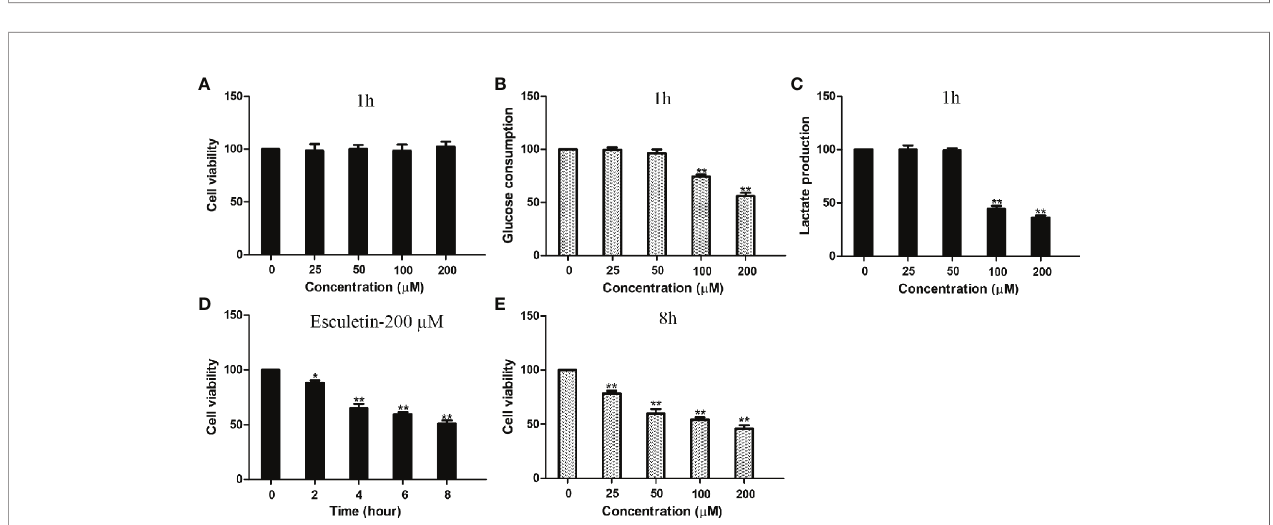
FIGURE 4 | Esculetin inhibit glucose consumption and lactate production, and are toxic to cells. (A) The survival of HepG2 cells exposed to 0 – 200 µM esculetin within 1 h. (B , C) Concentration-dependent inhibition of glucose consumption and lactate production in HepG2 cells by esculetin within 1 h. (D) Time-dependent survival of HepG2 cells exposed to 200 µM esculetin. (E) Sensitivity of HepG2 cells in 8 h toward series concentration of esculetin. Data are mean ± SD (n=3), *P < 0.05, **P < 0.01.